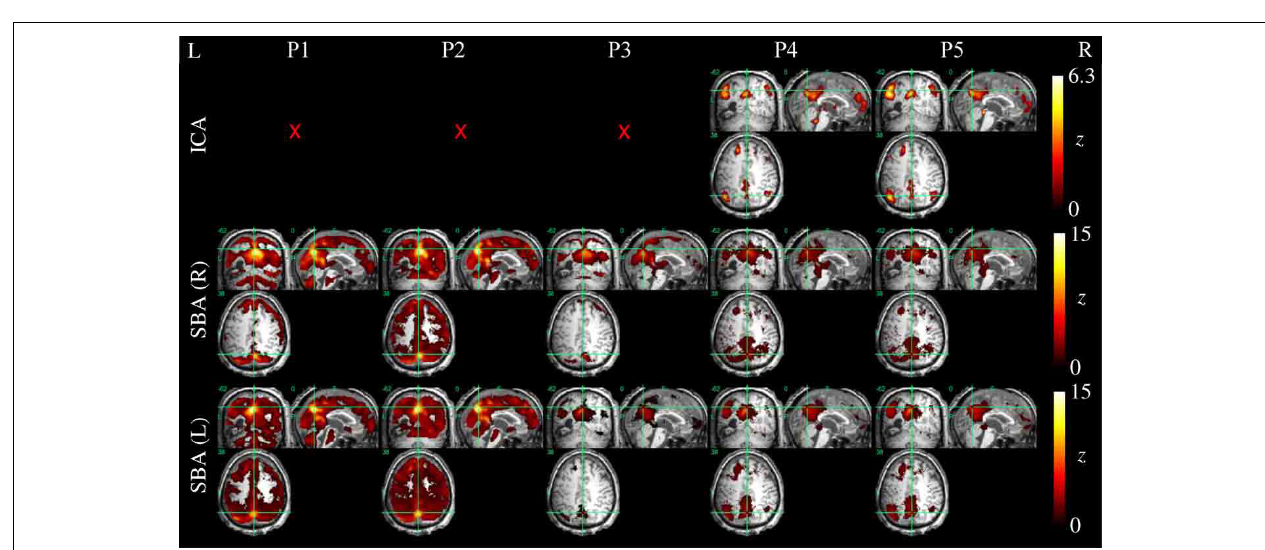
the right precuneus seed was not performed. Here, elevating preprocessing grade (left to right, P1–P5) revealed coherent activity between the left precuneus and angular gyrus: applying procedures 4 and 5, ICA decomposition became able to orthogonalize activity for this preserved DMN subset, and SBA maps were “cleaned” of unspecific physiological fluctuations that originally extended to areas of gross anatomical damage.